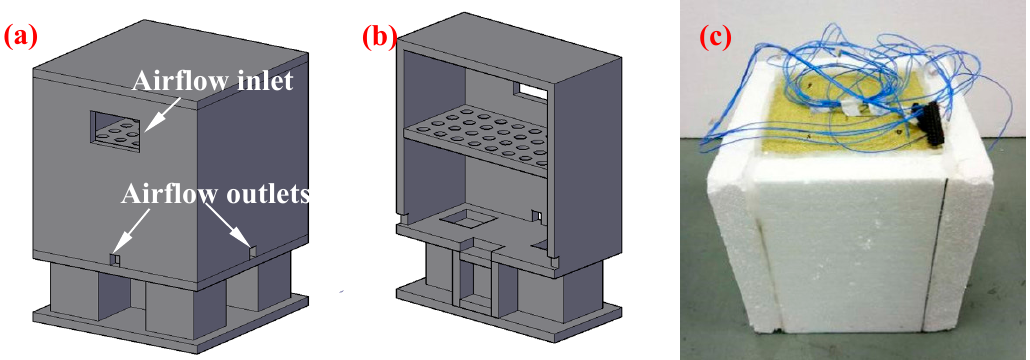
Figure 3. Schematic diagrams of thermal performance testing: ( a ) Testing system; ( b ) section of the testing system; ( c ) small house model.